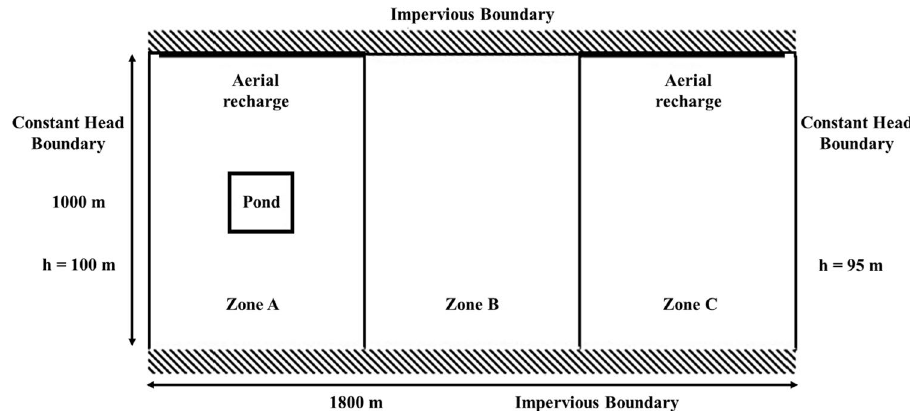
Fig. 1 Hypothetical aquifer configuration